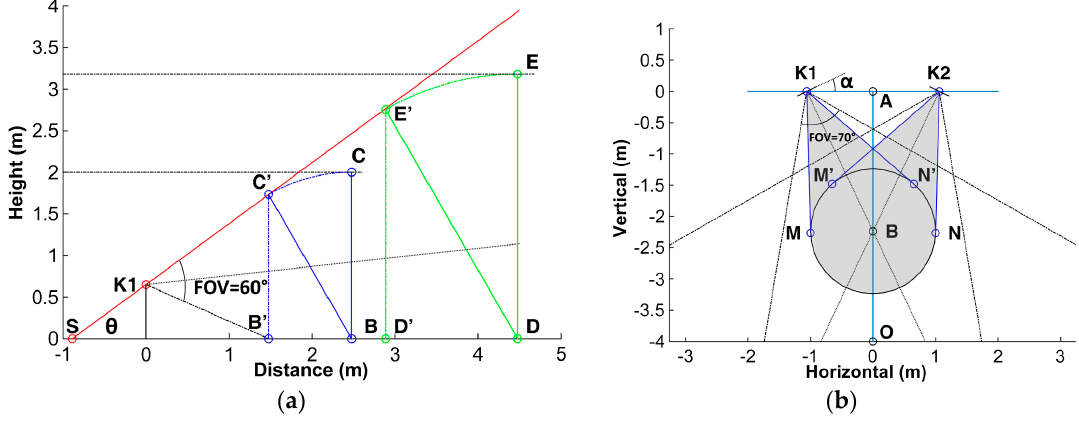
Figure 3. Illustration of duplex Kinect sensor placements. ( a ) the vertical field of view (FOV) of single Kinect sensor and setup for a 2 m high subject; ( b ) the positions, horizontal FOVs and required space (gray color) of the two sensors.